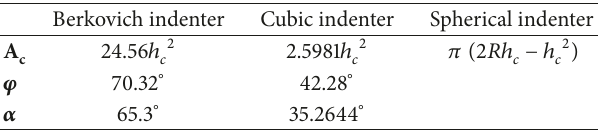
Table 1: Geometric parameters of different indenters. Berkovich indenter Cubic indenter Spherical